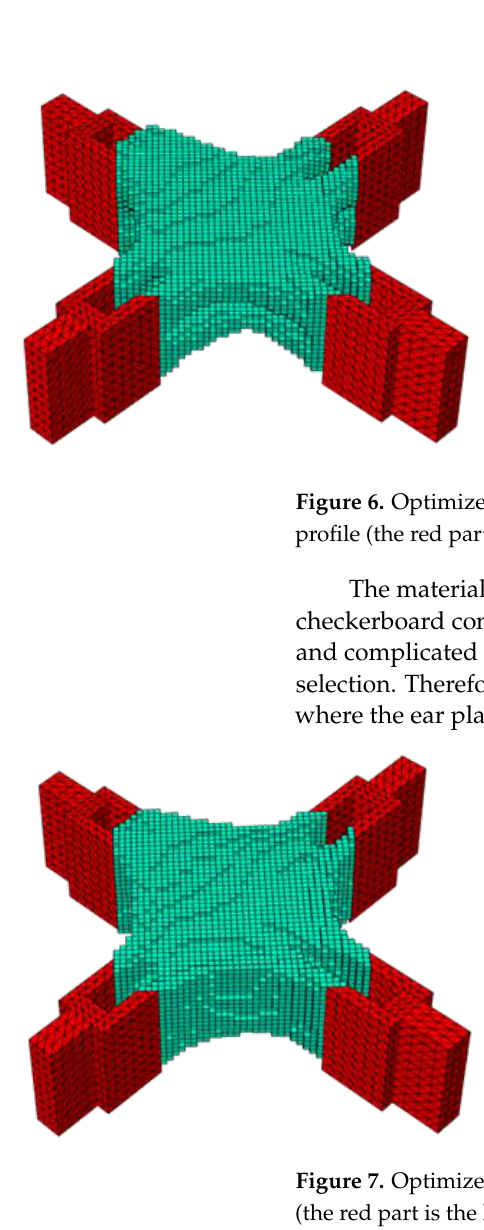
( c ) Figure 5. Schematic diagram of finite element application of different load cases (pink arrows are axial forces, yellow arrows are shear forces, orange and blue ends are where the boundary condi- tions are applied, and the green part is design domain): ( a ) shear load; ( b ) axial load; ( c ) combined load. In the figure, the blue area on the end face is the fixed end of the boundary; the pink load is the axial force, which was uniformly applied to the end face of the ear plate in the form of surface load; and the yellow arrow is the shear force, which was applied to the end face of the ear plate in the form of a point load. 3.2. Optimization Effect before and after Improvement The optimization results need to consider the influence of boundary burrs and check- erboards in actual applications. The improved material interpolation method greatly weakened the impact of the penalty index p , and the penalty effect was more dependent on the gap between the material properties. When the material properties of the soft ele-